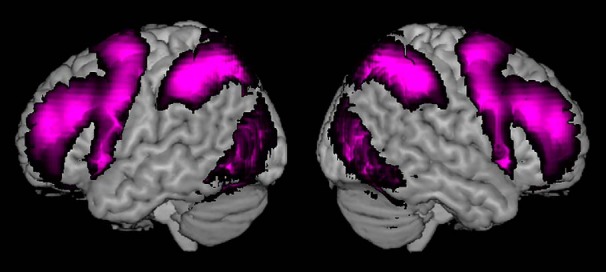
Neuroanatomical extend of the multiple demand network or MD cortex, based on averaged unthresholded activity of seven diverse task sets (Fedorenko et al., 2013).